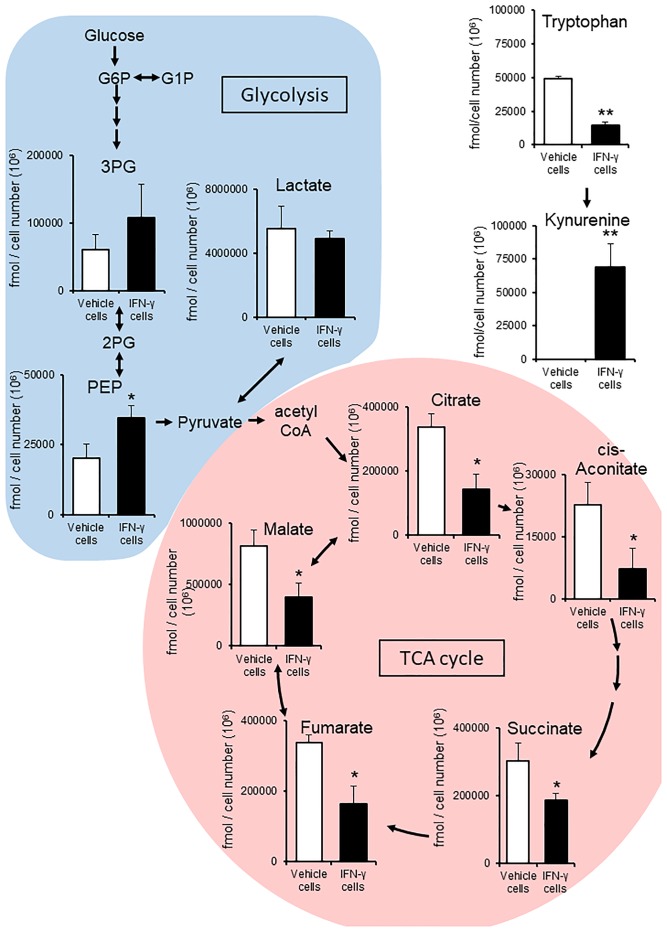
Metabolome data map of metabolites involved in the glycolysis, TCA cycle, and tryptophan catabolism pathways, as detected in D3H2LN cells treated with or without IFN-γ.(A) After IFN-γ treatment, there was a significant difference in the amount of components related to glycolysis and the TCA cycle; PEP (P = 0.041), citrate (P = 0.011), cis-aconitate (P = 0.040), succinate (P = 0.042), fumarate (P = 0.011), and malate (P = 0.028). (B) The amounts of tryptophan (P = 6.4E-5) and kynurenine (P = 0.010), components of tryptophan catabolism. Kynurenine increased significantly in the presence of IFN-γ. Columns, average concentration (fmol/cell number (106)); bars, S.D. (n = 3). *P < 0.05, **P < 0.01 (Student’s t-test). PEP, phosphoenolpyruvate. All experiments were performed using three biological replicates.